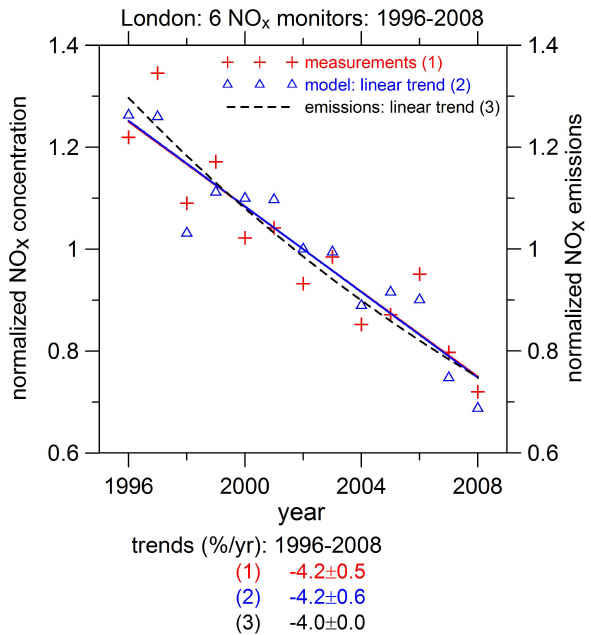
Fig. 9. Comparison of (1) air quality monitoring data in London with (2) simulations based on the relative linear trend in NO x emis- sions. The trend estimated as an exponential fit to emission esti- mates derived from satellite data is also shown (3). The range of uncertainties reported along with values of trends is estimated as the standard deviation of the slope of the linear fit.